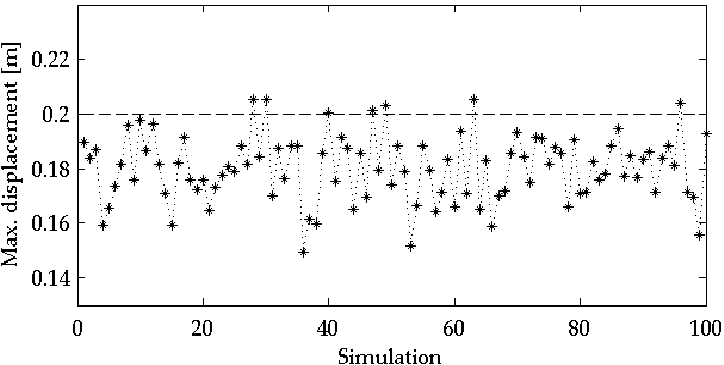
Figure 8. Maximum displacement at the mid-span of the stay cable damped by the friction damper for the different elements of the